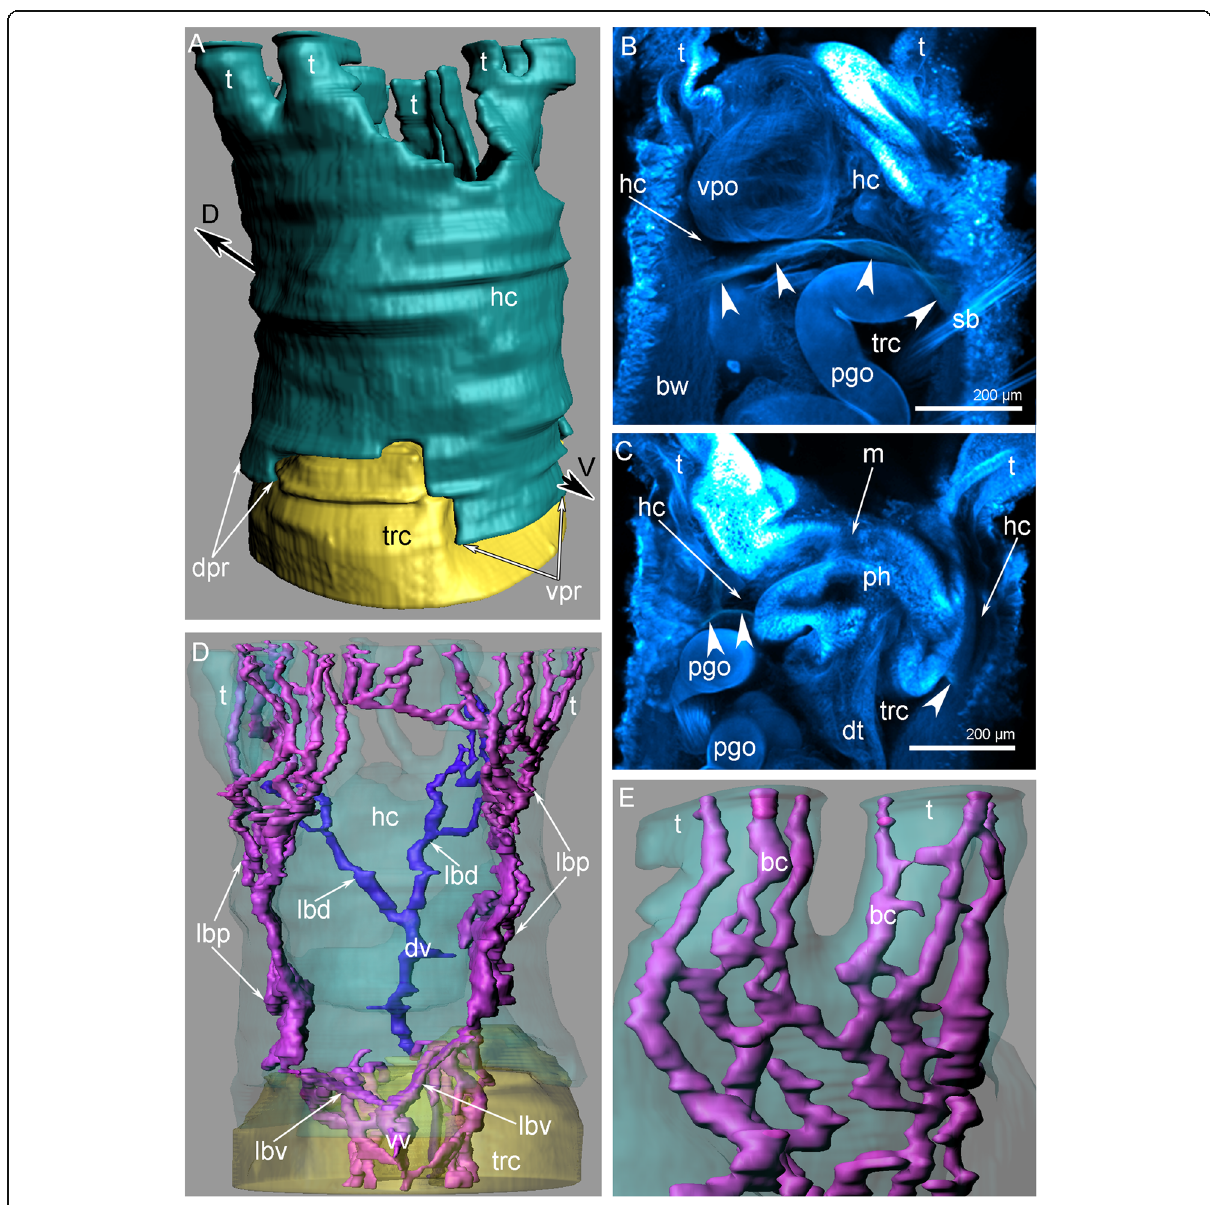
Fig. 5 Organization of the coelom of the head of Owenia borealis . A Three-dimensional reconstruction of head (green) and trunk (yellow) coeloms. B Z-projection of head after staining with DAPI: dissepiment between head and trunk coeloms is indicated by arrowheads. C Z- projection of head and trunk cavity at sagittal optical section after staining with DAPI: dissepiment between head and trunk coeloms is indicated by arrowheads. D Three-dimensional reconstruction of blood vessels in head and part of trunk. Trunk and head coeloms are partly transparent. E Three-dimensional reconstruction of blood capillaries in tentacles. Abbreviations: bc – blood capillary; bw – body wall; dpr – dorsal protrusion; dt – digestive tube; dv – dorsal blood vessel; hc – head coelom; lbd – lateral branch of dorsal blood vessel; lbv – lateral branch of ventral blood vessel; lbp – lateral blood plexus; m – mouth; pgo – parapodial glandular organ; ph – parynx; t – tentacle; sb – setae bundle; trc – trunk coelom; vpo – ventral pharyngeal organ; vpr – ventral protrusion of the head coelom; vv – ventral blood